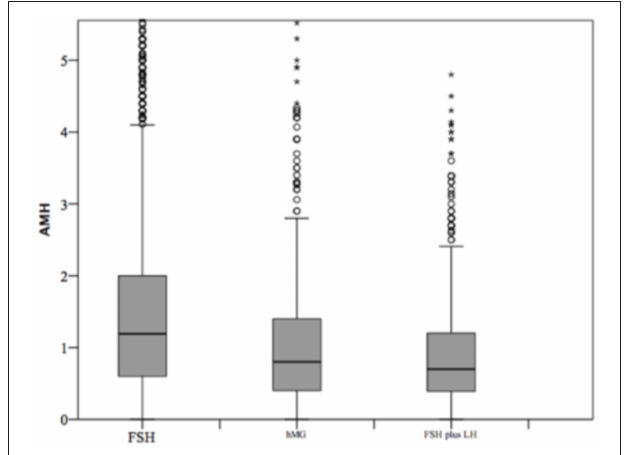
FIGURE 4 | Anti-Mullerian hormone (AMH) among groups of patients, divided according to gonadotropins regimen chosen. * p < 0.05.